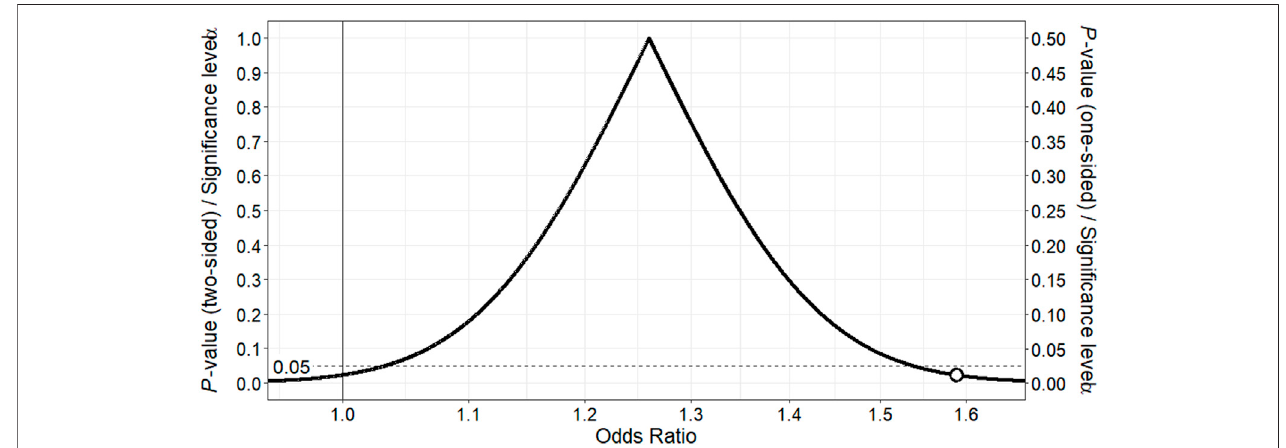
FIGURE2 | p -value function for oddsratio for association between citalopram or escitalopram and ventriculardysrhythmia or sudden death in methadone-treated patients.The point estimate of 1.26 corresponds to the peak of the p -value function. The vertical continuous line denotes the null value for the odds ratio, and the white point the counter-null value of 1.59, which is the effect size supported by the same amount of evidence as the null value.